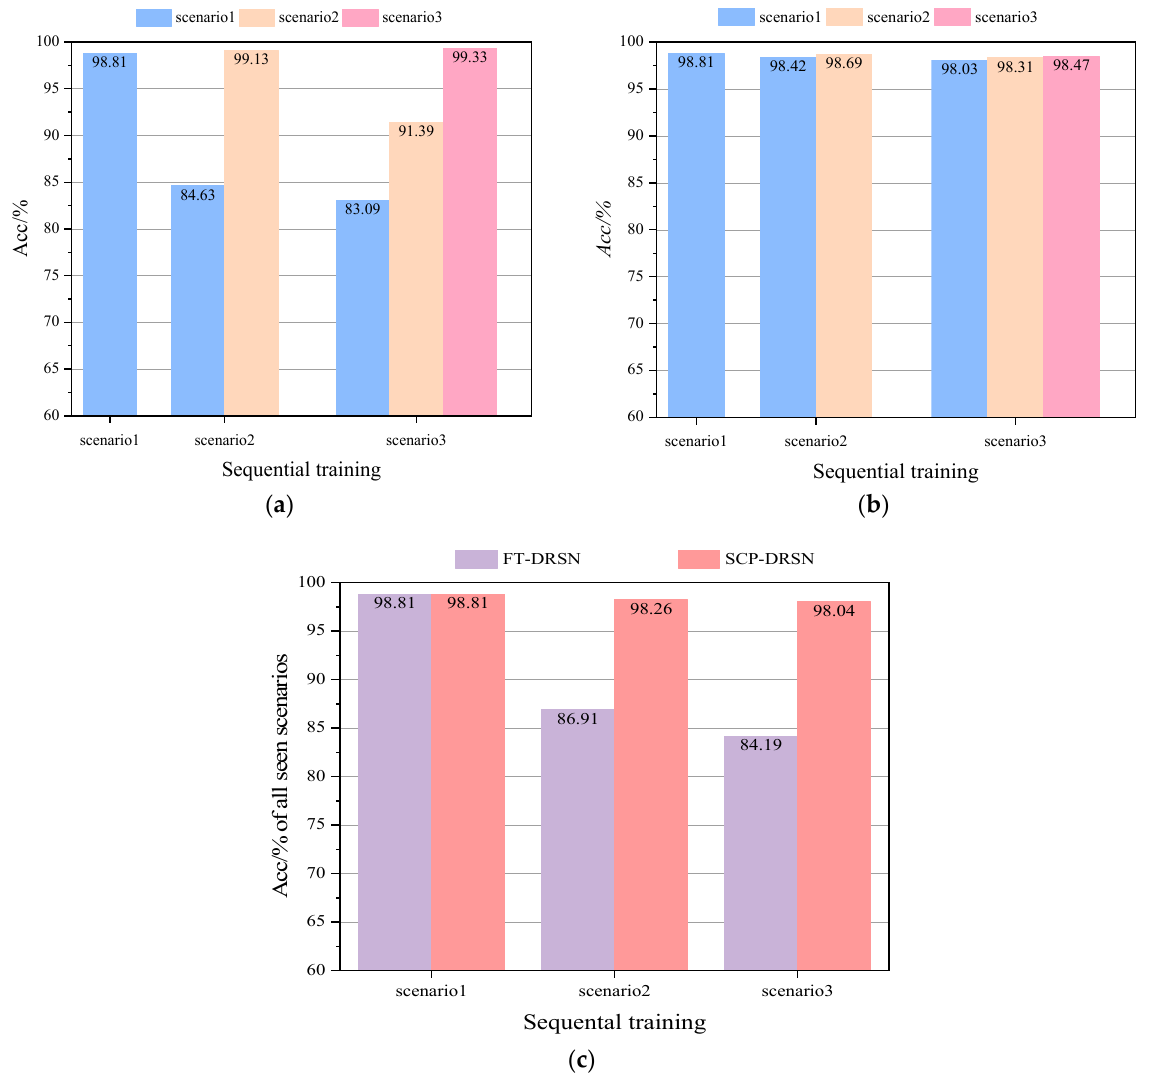
Figure 10. Acc comparison of two different update schemes on the modified New England 39-bus system: ( a ) Acc comparison of FT-DRSN in different scenarios, ( b ) Acc comparison of SCP-DRSN in different scenarios, and ( c ) Acc comparison in all seen scenarios.